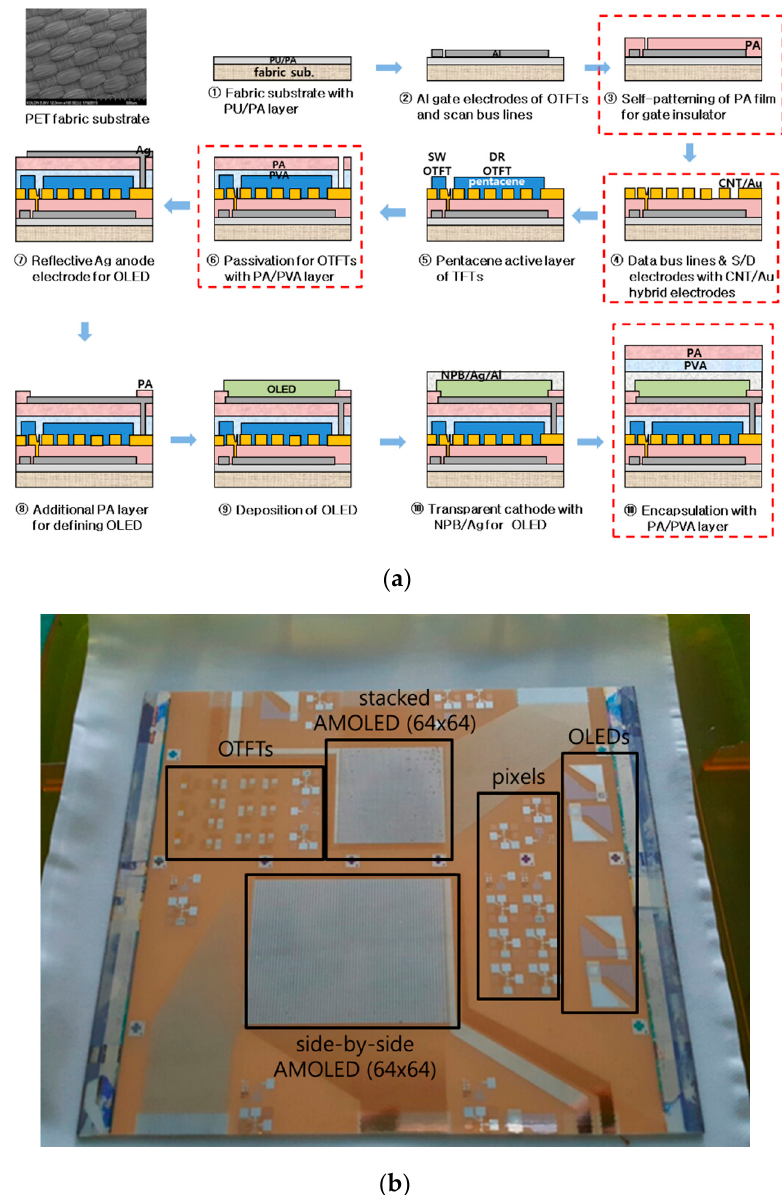
Figure 2. ( a ) The fabrication processes for the AMOLED panel using the stacked pixel and ( b ) a picture of two AMOLED panels, using the stacked and the side-by-side pixels, fabricated on a polyethylene terephthalate (PET) fabric substrate with the various test elements included.